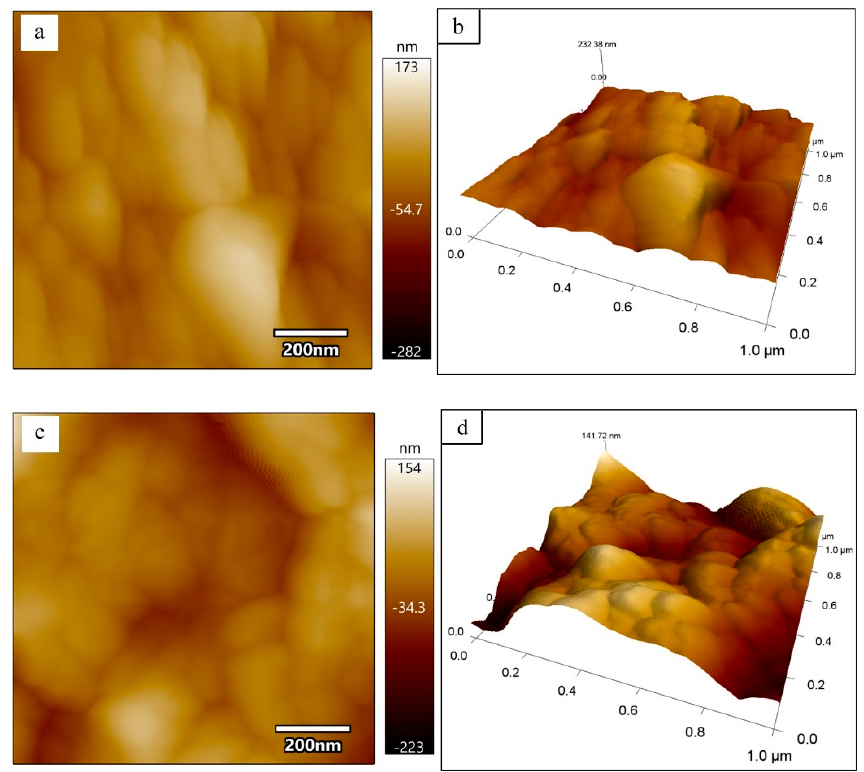
Figure 4. Morphology of ( a ) and ( b ) PDMCSH00; ( c ) and ( d ) PDMCSH50.